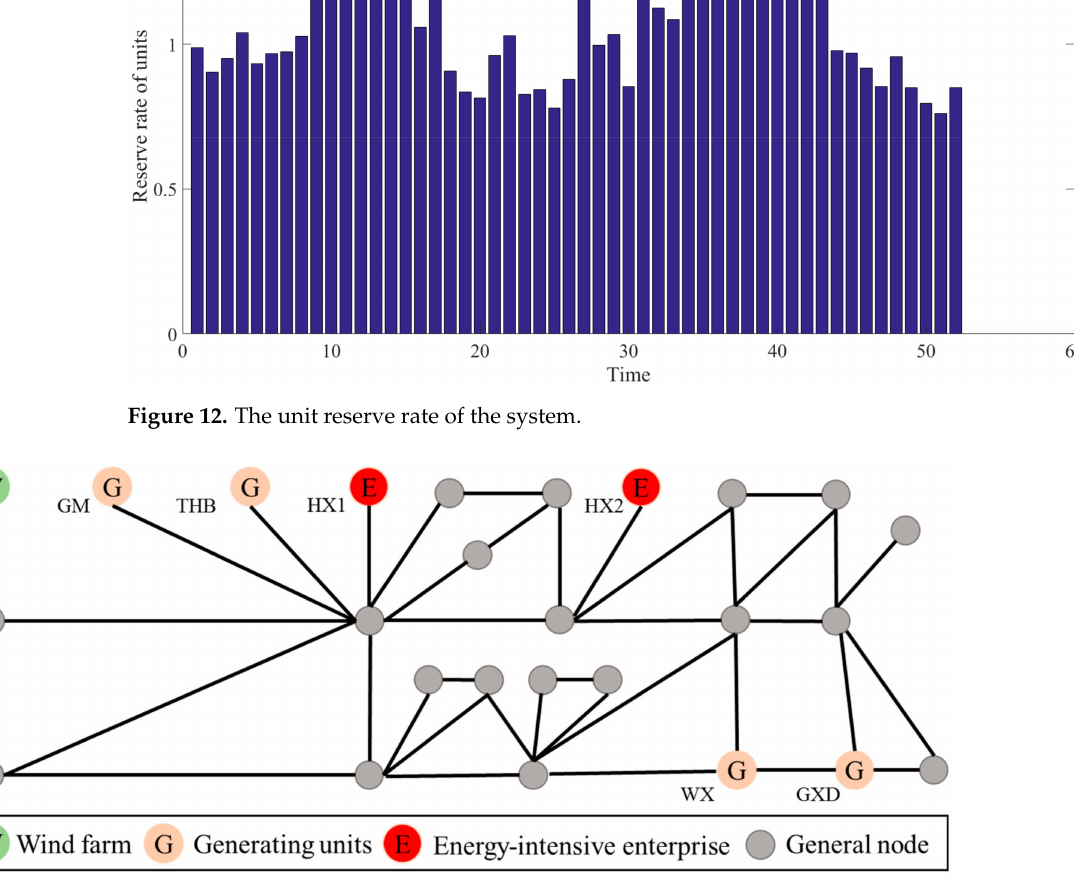
Figure 13. The topology of actual power grid in Southwest